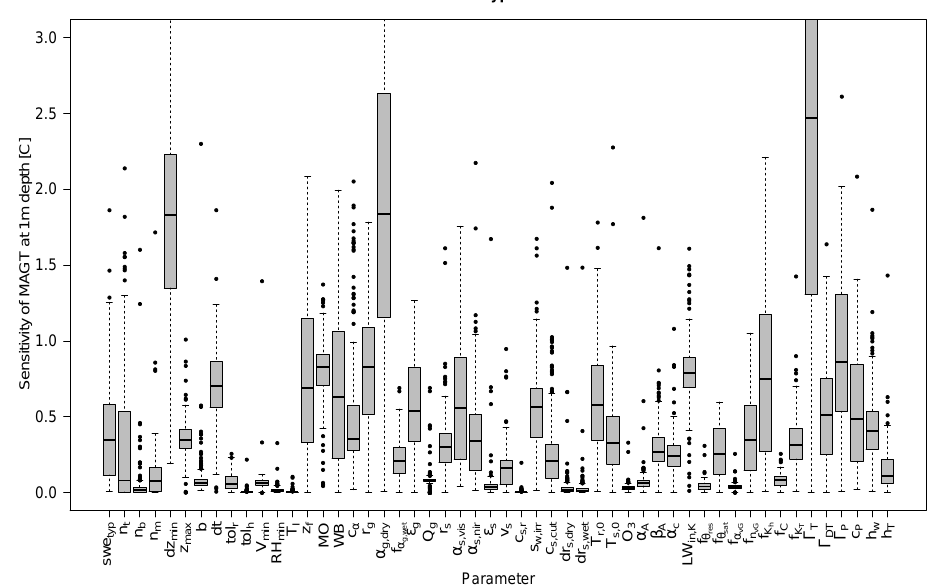
Fig. 5. Sensitivities of the target variable MAGT at 1m depth [ ◦ C] for sandy ground. The sensitivities of the topographic locations are summarized as box plots. The greater the spread of the box, the higher the variability of the sensitivity within the topographic setting. The range of the box plots is equivalent to the “potential of being mislead” by the results of a sensitivity analysis performed at one single location. See Table 3 for an explanation of parameter